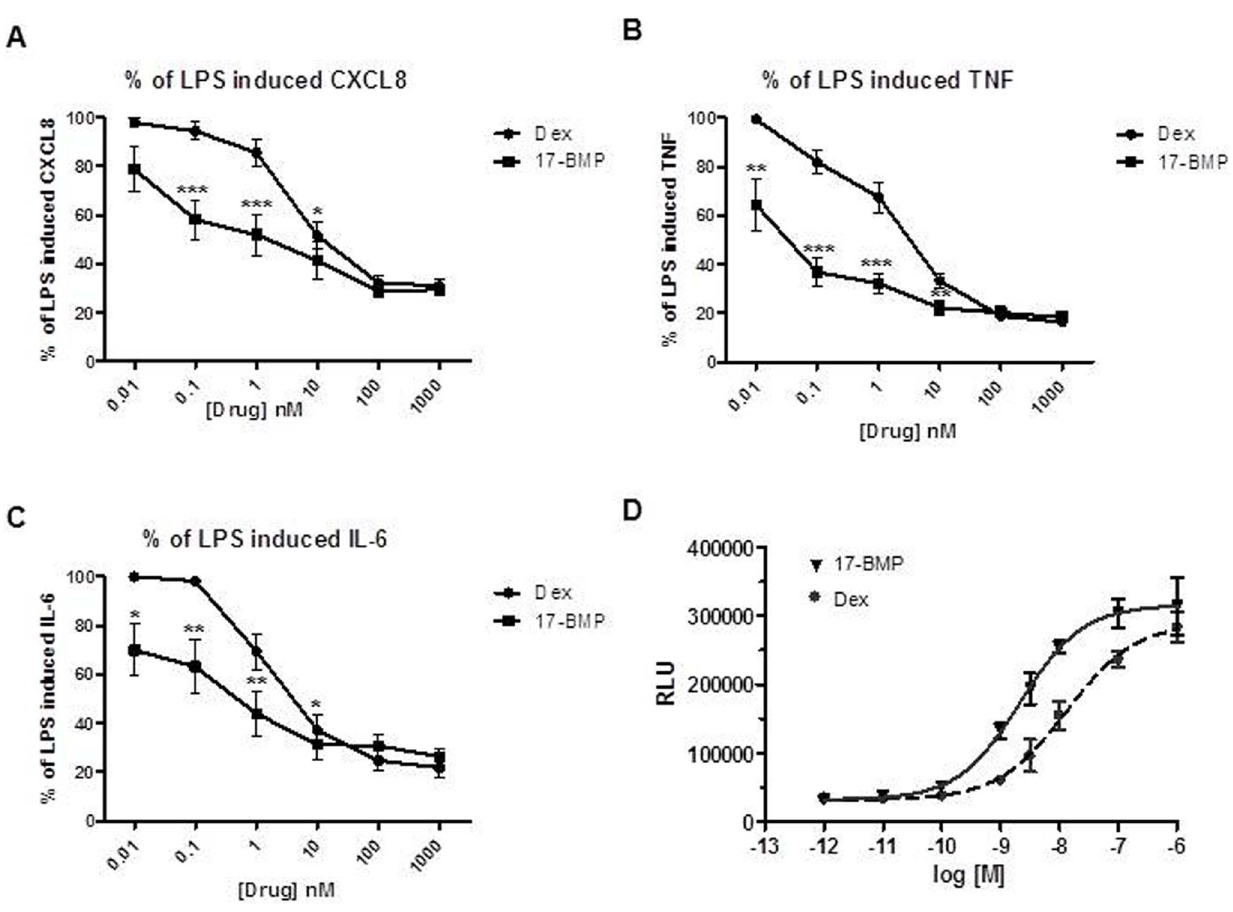
Figure 4. Comparative potency of 17-BMP and dexamethasone on LPS-stimulated cytokine production and nuclear translocation. Lung macrophages (COPD n=9) were stimulated for 24 hours with LPS (1 m g/ml) after a 2 h pre-incubation with 17-BMP (0.01–100 nM) or dexamethasone (0.01–1000 nM). Data shown are mean 6 SEM percentage of LPS effect constrained to 100% for the production of (A) CXCL8, (B) TNF a and (C) IL-6 ELISAs. Two-tailed paired t-tests were performed at each concentration; * P , 0.05, ** P , 0.01, *** P , 0.001. (D) Concentration- response curves in CHO-K1 PathHunterTM cells incubated with 17-BMP or dexamethasone (1 6 10 2 12 –1 6 10 2 5 M) for 3 h. Data shown are mean 6 SD of a representative experiment performed in triplicate.